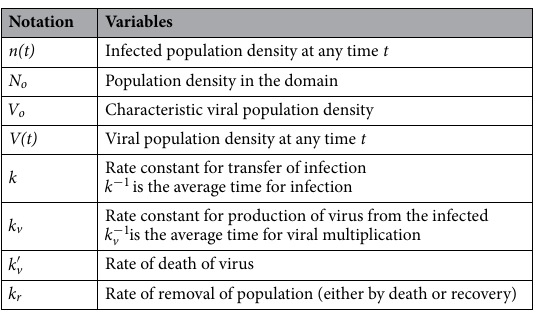
Table 2. Variable definitions in